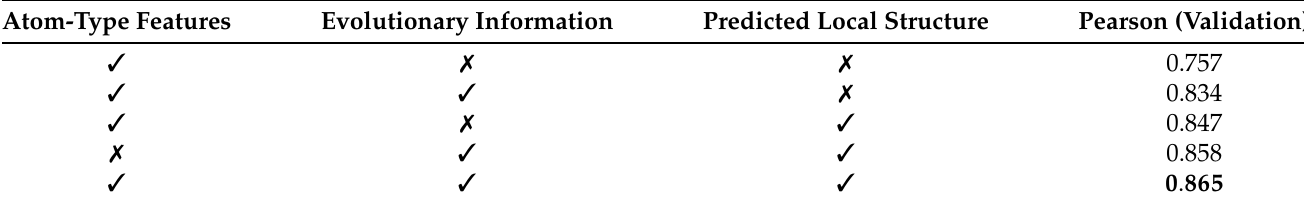
Table 2. Prediction performance for the combination of each feature.